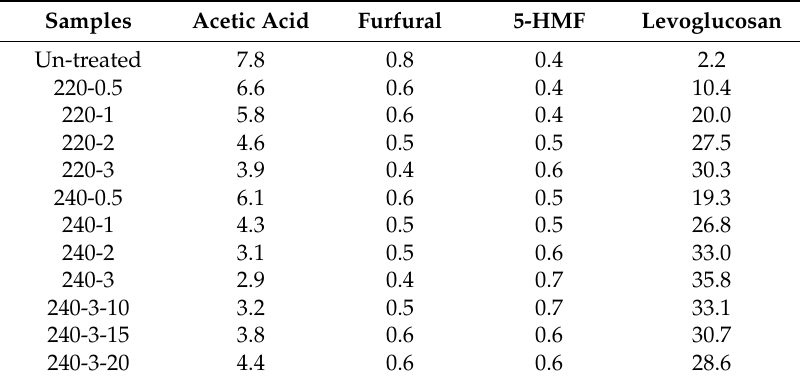
Table 6. Yields of main compounds from un-treated and glycerol pretreated corncobs in fast pyrolysis. 5-HMF: 5-hydroxymethylfurfural.